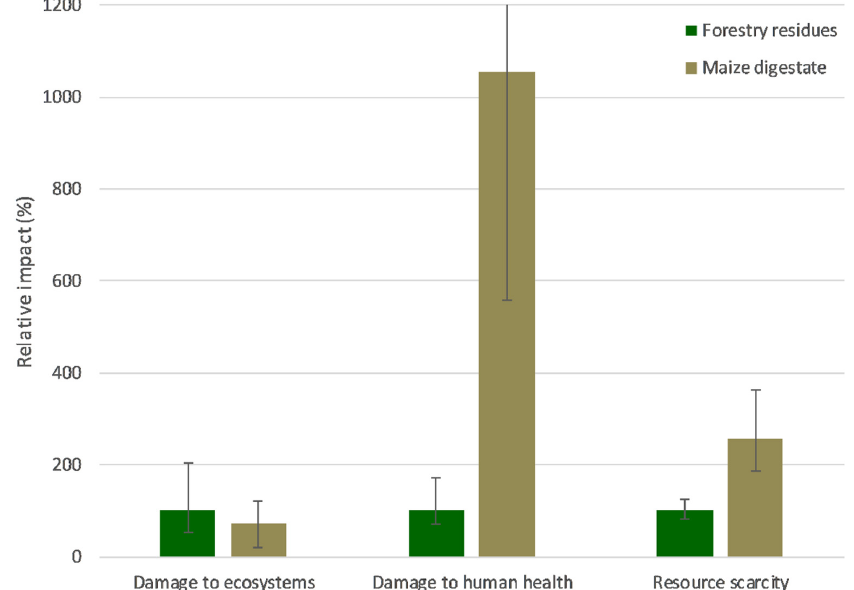
Figure 2. Relative environmental impact of 1 GJ pyrolysis oil from maize digestate compared to forestry residues. The impact of forestry residues was set at 100%. Error bars represent the 95%